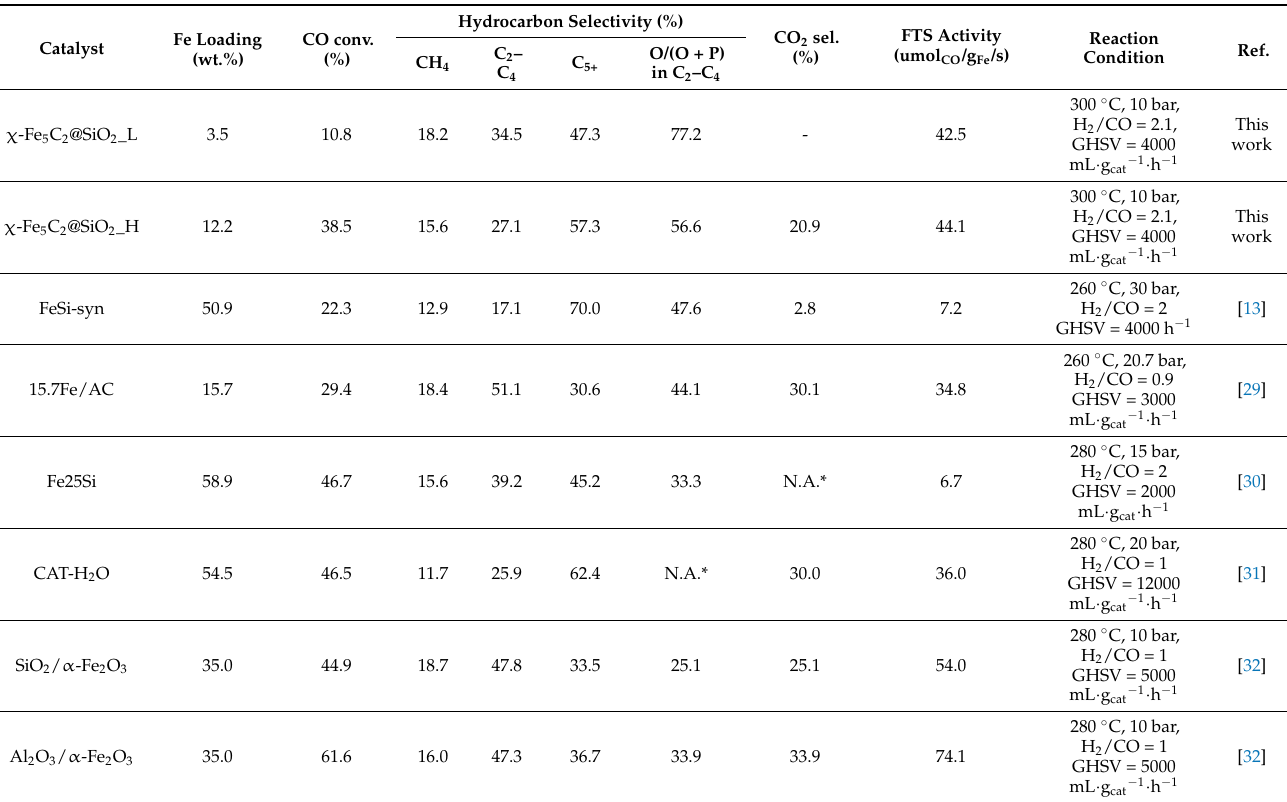
Table 1. CO conversion, CO 2 and hydrocarbon selectivity, and FTS activity of χ -Fe 5 C 2 @SiO 2 _L, χ -Fe 5 C 2 @SiO 2 _H, and other reference